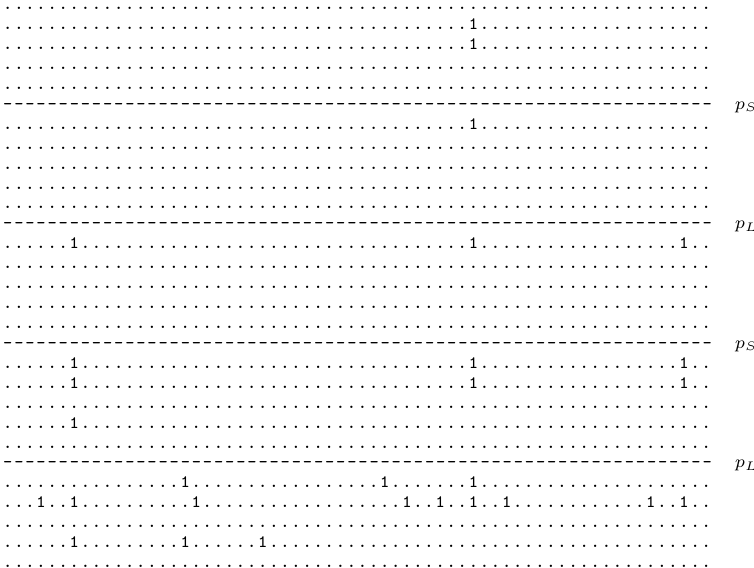
Figure 2: 3-round trail with 16 [1, 3, 12] active Sboxes and weight 46 [2, 6,